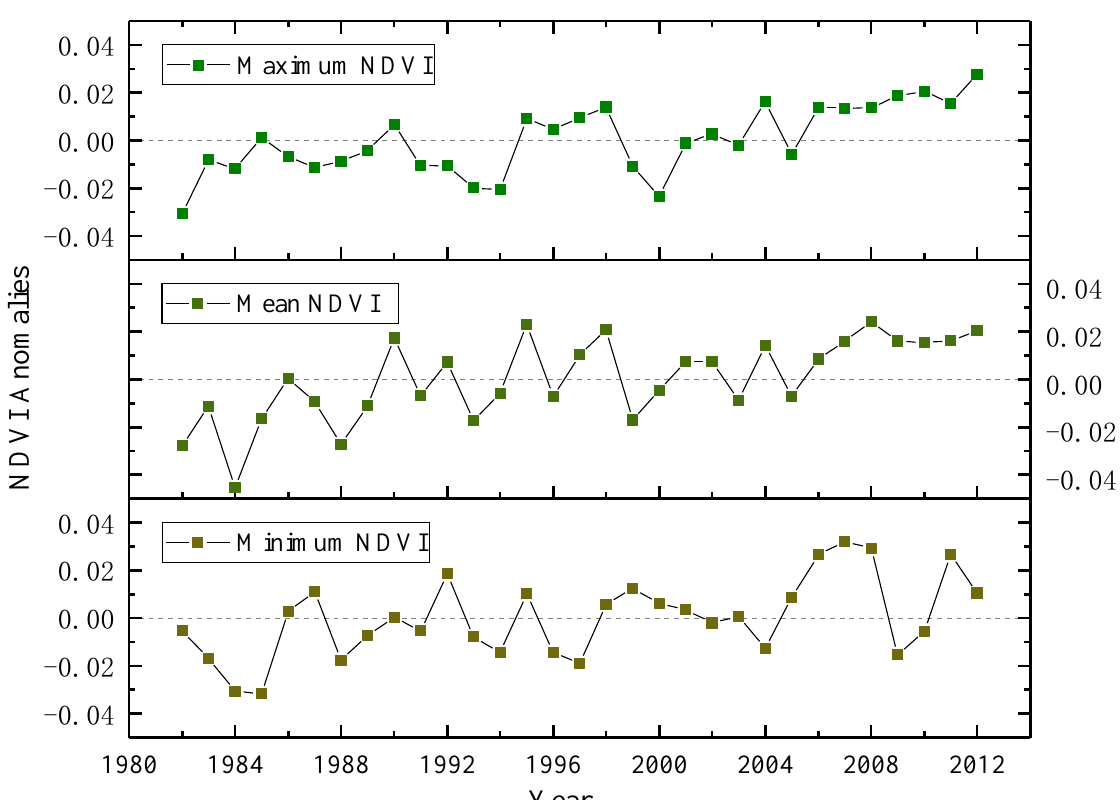
Figure 4. Anomalies of minimum, mean and maximum NDVIs in the MLR-YR from 1982 to 2012. We further explored the temporal trends and the standard deviation of the three NDVI indices in the MLR-YR from 1982 to 2012. Similar patterns were found between the standard deviation of the minimum, the mean and the maximum NDVIs, and their temporal trends (not showed here), respectively. Taking the standard deviation analysis as an instance, we analyzed the differences among all the three NDVI indices. Concretely, the standard deviation of the minimum, mean, and maximum NDVIs ranged from 0 to 0.129, 0 to 0.177, and 0 to 0.250, respectively. As shown in Figure 5a–c, the standard deviation of the three NDVI indices was relatively small in the southwestern MLR-YR over the period 1982–2012. However, obvious differences were found in the regions where a large standard deviation exists. For instances, it revealed a large standard deviation of the mean NDVI in the northwestern MLR-YR, including the Hanjiang River Basin. In contrary, the standard deviation of the minimum and maximum NDVIs was relatively large in northeastern MLR-YR. As to the maximum NDVI, a large standard deviation was mainly distributed in Danjiangkou-Hanjiang, Poyang-Yangtze, Dongting-Yangtze, and Taihu-Chaohu-Yangtze